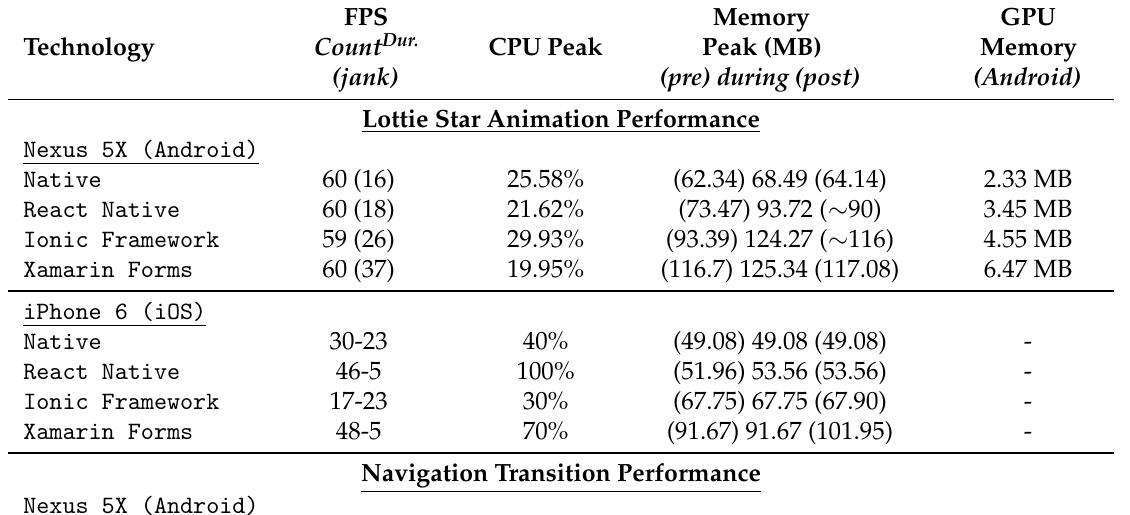
Table 4. Results from Performance